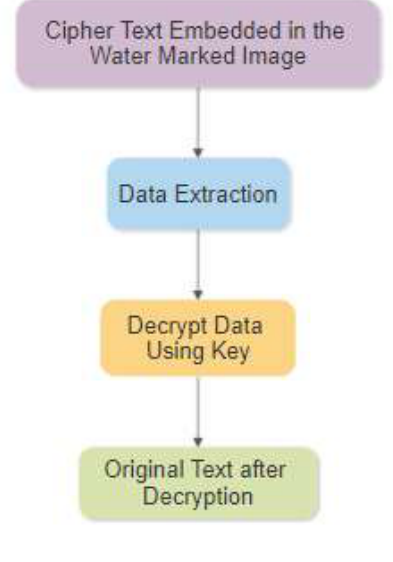
Figure 2 : Patient's Data Decryption